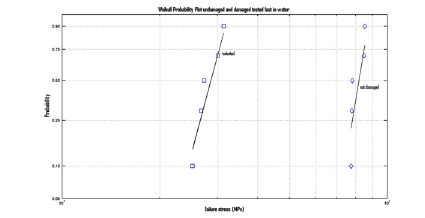
Figure 7: Weibull plot of slow tests in air on normal and indented specimens.